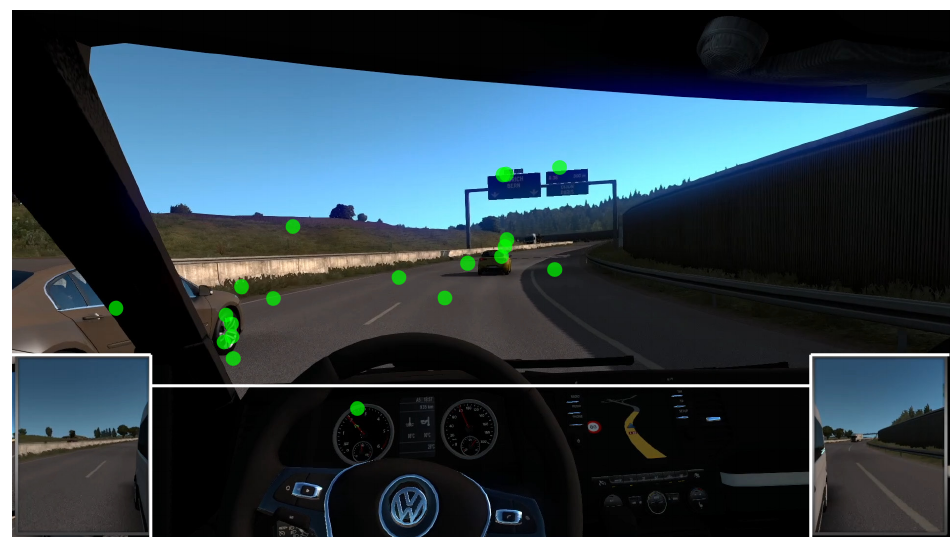
Figure 4. Moment in Video 3 where most participants attended to the windshield (Baseline Task). The green markers represent the gaze coordinates of individual participants. White lines are drawn around the AOIs.